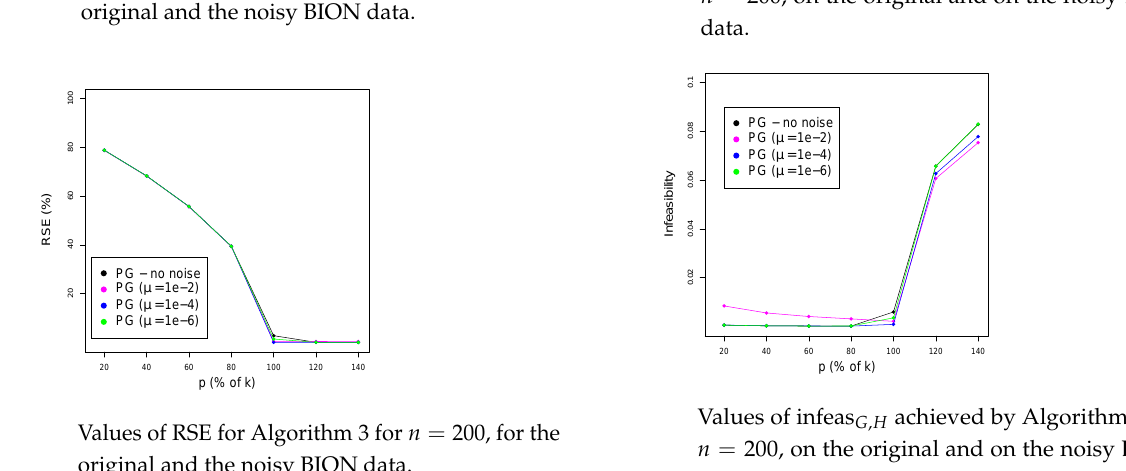
Values of RSE for Algorithm 2 for n = 200, for the original and the noisy BION data.